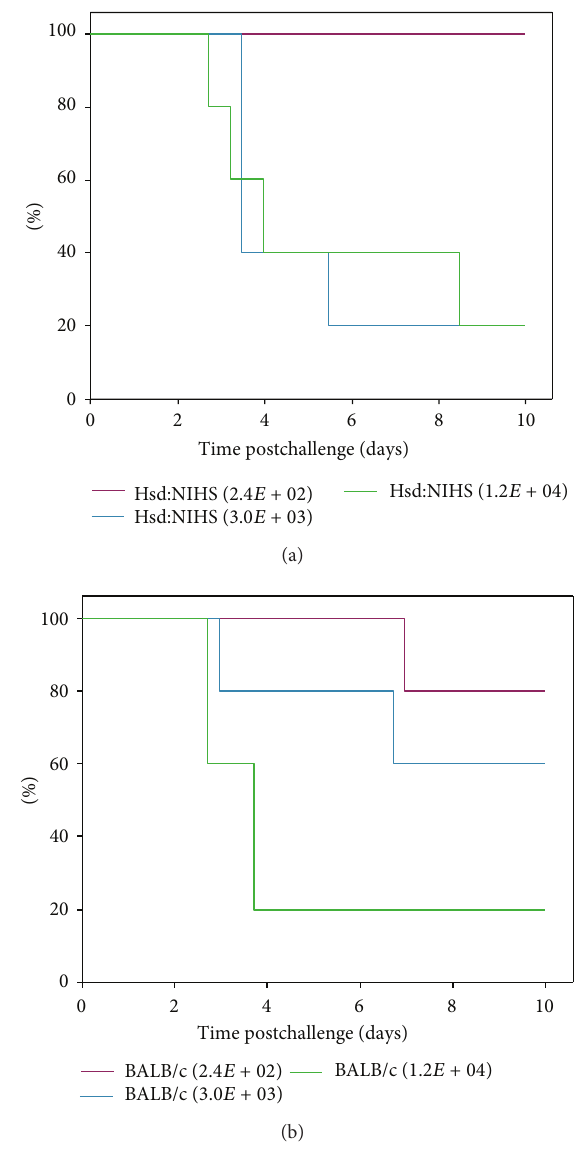
Figure6:MousestrainBALB/candHsd:NIHShadsimilarsuscepti- bly to aerosolised Y. pestis. (a) shows the survival plots for Hsd:NIHS and (b) shows the survival plots for BALB/c mice. Study (4), 𝑛 = 5 per group. The MTD was calculated using a Kaplan-Meier survival